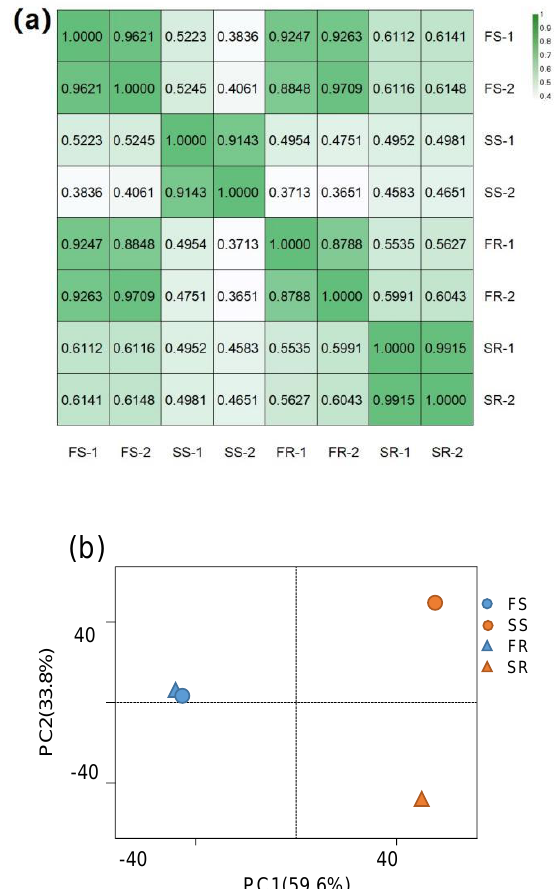
Figure 3. Quality assessment of transcriptomes. ( a ) Spearman’s correlation analysis between biolog- ical replicates for RNA-seq. Color levels correspond to the degree of correlation in each replicate. ( b ) Principal component analysis (PCA) of the whole transcriptome in cassava samples.